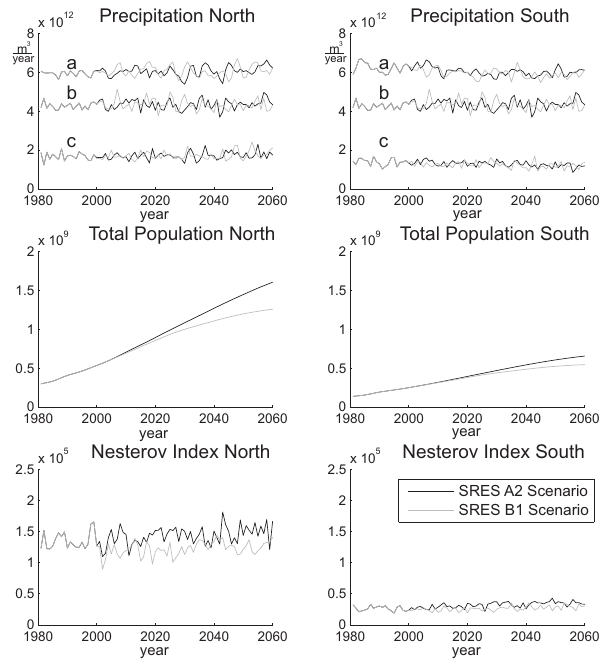
Fig. 2. Simulated climate and population variables used to project the burned area until the year 2060, taken from the two SRES story- lines A2 and B1 and ECHAM climate model projections. The time period from 1980 to 2000 is calculated from the control simulation of the 20th century and is therefore similar in both scenario runs. For details of the used data sets see the Methods section. Upper panels: total precipitation: lines a: mean annual precipitation over the last 4 seasons (covering 2 years); lines b: total precipitation dur- ing the wet season; lines c: total precipitation during the dry season; middle panels: total population, lower panels Nesterov index, mean of maximum values of each